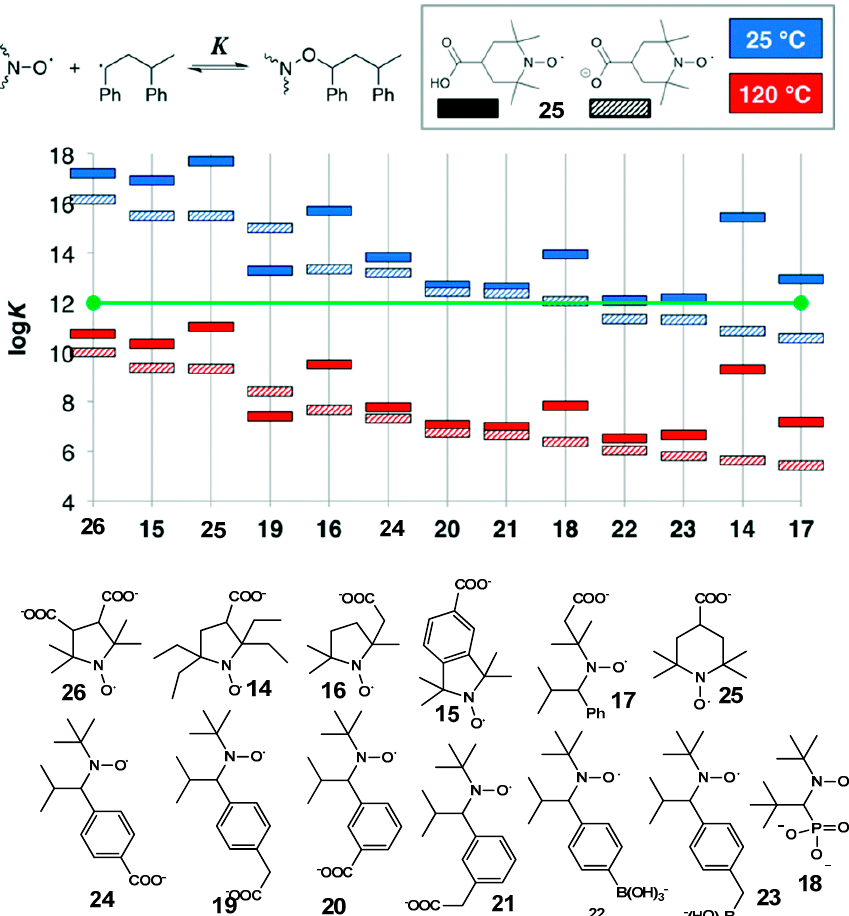
Figure 7. Logarithms of equilibrium constants for NO–C bond homolysis (a combination is defined as the forward reaction, and decomposition as the reverse one) obtained from the bond dissociation free energies for the tested nitroxides with a styryl dimer as a propagating radical, calculated for a bulk styrene solution at 25 and 120 °C. The green line corresponds to log K = 12 (corresponds to the TEMPO-Sty alkoxyamine used as a reference). Structures of only the anionic forms are depicted. Adapted from Ref. [33] with permission from the PCCP Owner Societies.